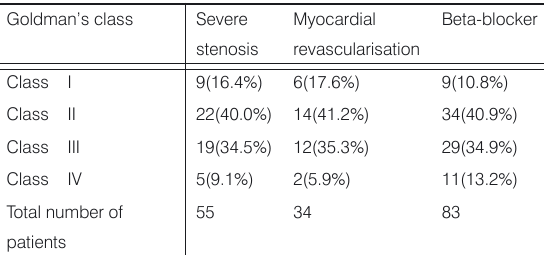
Table 3. Perioperative management - Risk reduction strategy in coronary